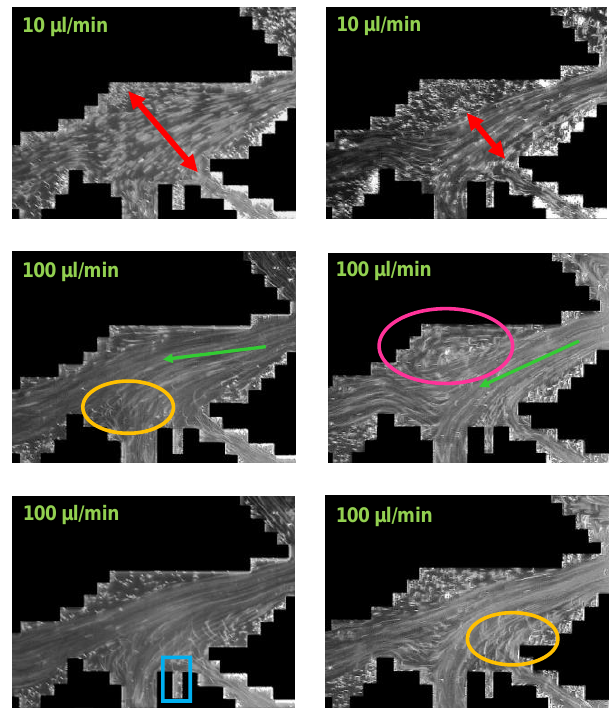
Figure 7. Streamline visualization for a viscoelastic 1000 ppm polymer solution in a glass-silicon-glass (GSG) micromodel (modified after Hincapie et al. [29]).